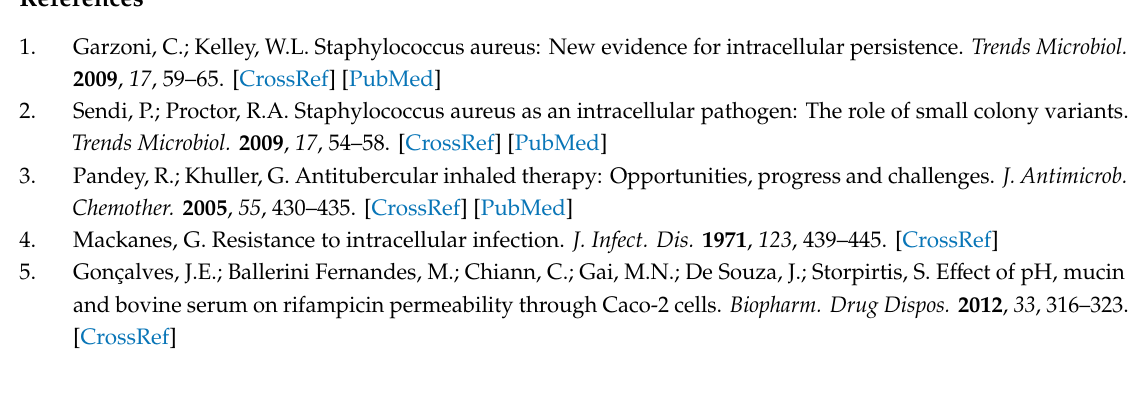
Figure S1: Nitrogen adsorption / desorption isotherms and BJH pore size distribution of MSN. Figure S2: Total internal reflection micrographs of semi-native